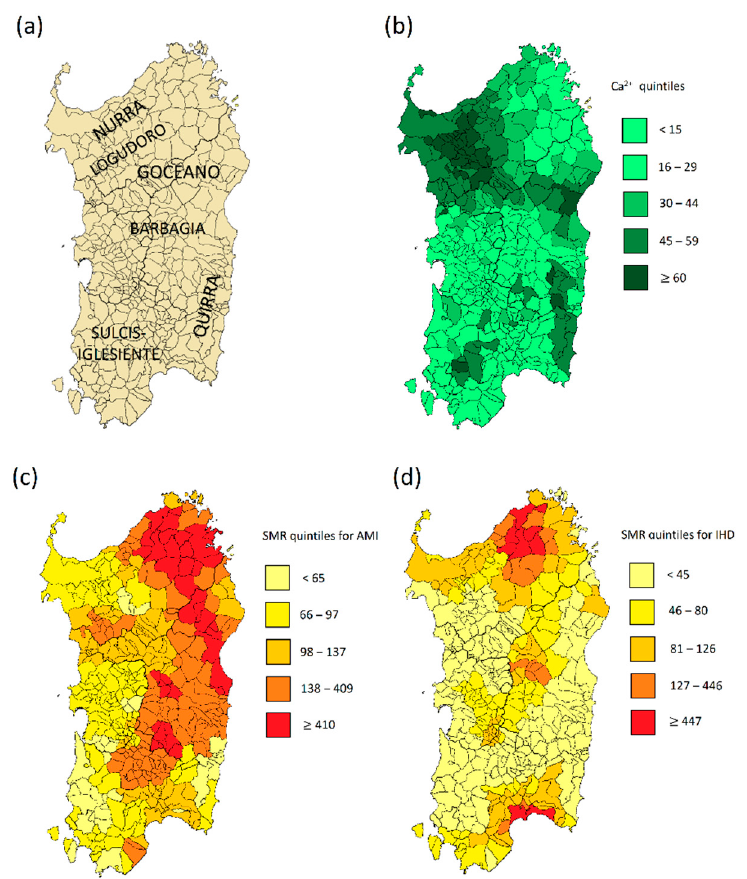
Figure 2. ( a ) subregions of Sardinia; ( b ) Ca 2+ concentration in spring waters; ( c ) standardized mortality ratio (SMR) for acute myocardial infarction (AMI); ( d ) standardized mortality ratio for ischemic heart disease (IHD).